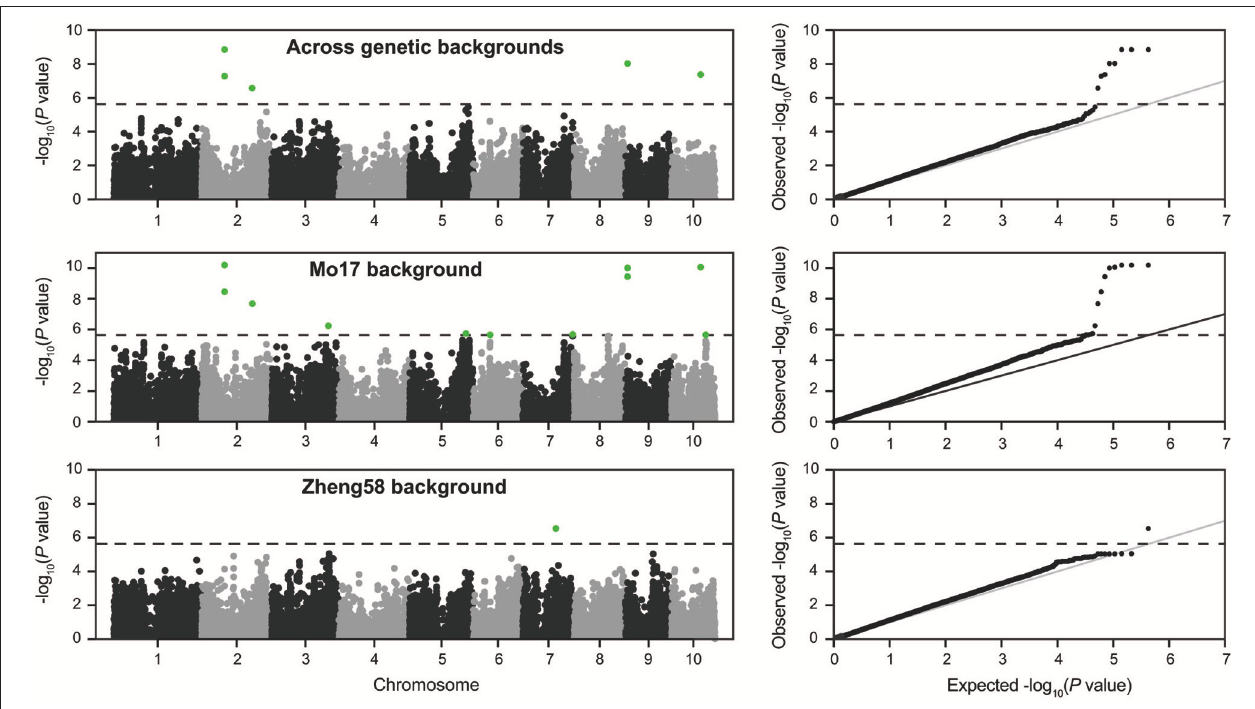
FIGURE 3 | Manhattan plots from the association scans for haploid male fertility across genetic backgrounds and in the “Mo17” and “Zheng58” backgrounds. The dashed horizontal line indicates the significance threshold. In addition the quantile-quantile plots for expected and observed –log 10 ( P -values) are shown.